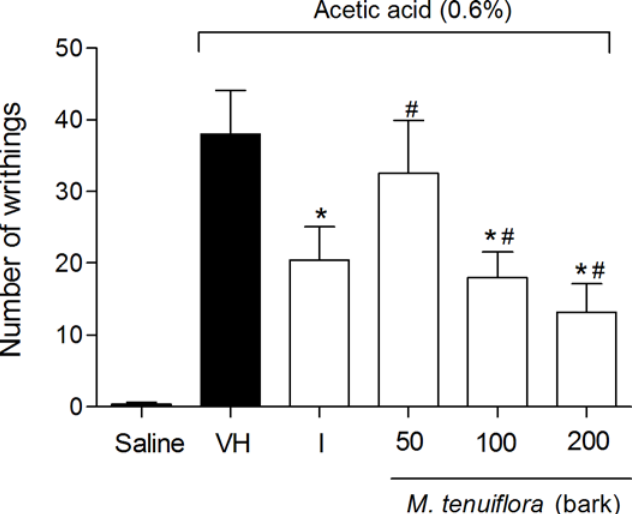
Fig 2. Effect of pretreatment of the mice with 50, 100 or 200 mg/kg of the ethanolic extract of M . tenuiflora bark on writhing induced by acetic acid (0.6%). VH is the vehicle group (negative control) and I is the positive control employing indomethacin (10 mg/kg, i.p.). The extract ethanol of M . tenuiflora bark was tested at doses of 50, 100 or 200 mg/kg (s.c.). The results are presented as the means ± S.D. of writhing in mice (n = 8). Statistical significance was calculated by ANOVA followed by Bonferroni's test. * P < 0.05 compared to the vehicle-negative control treated group. # P > 0.05 compared to the indomethacin — positive control